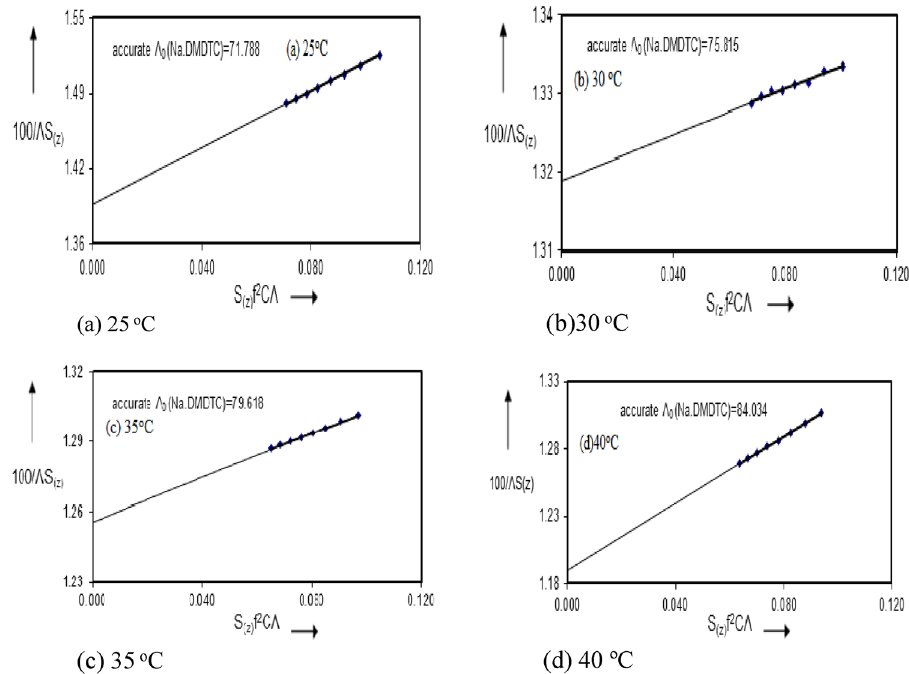
Figure 3. (F.K.S) plots for Sodium N , N -Dimethyl dithiocarbamate in Dimethylformamide at ( a ) 25 °C, ( b ) 30 °C, ( c ) 35 °C and ( d ) 40 °C.